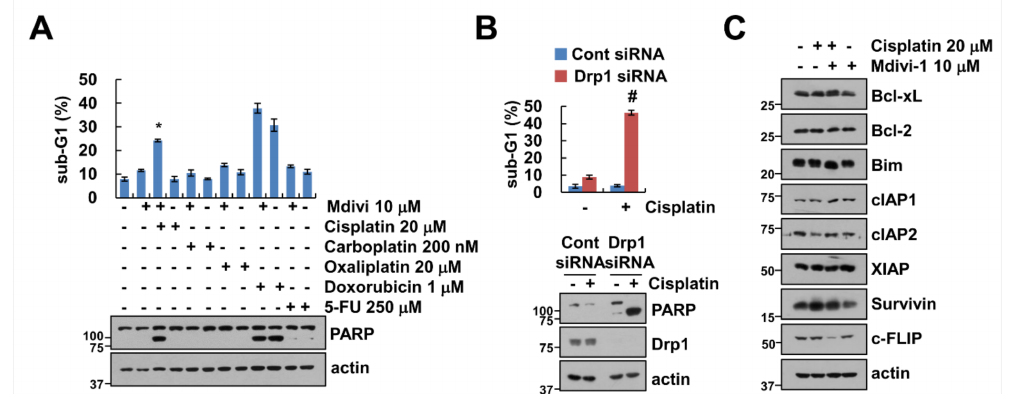
Figure 2. Mdivi-1 increases cisplatin-mediated apoptosis. ( A ) Caki-1 cells were treated with a combination of 20 µ M cisplatin, 200 nM carboplatin, 20 µ M oxaliplatin, 1 µ M doxorubicin, and 250 µ M 5-FU in the presence or absence of 10 µ M mdivi-1 for 24 h. ( B ) Caki-1 cells were transfected with Cont or Drp1 siRNA and were treated with 20 µ M cisplatin for 24 h. The sub-G1 population and protein expression were detected by flow cytometry ( A , B ) and Western blotting ( A – C ), respectively. The values in graph ( A , B ) represent the mean ± SEM of three independent experiments. * p < 0.01 compared to the control. # p < 0.01 compared to cisplatin in Drp1